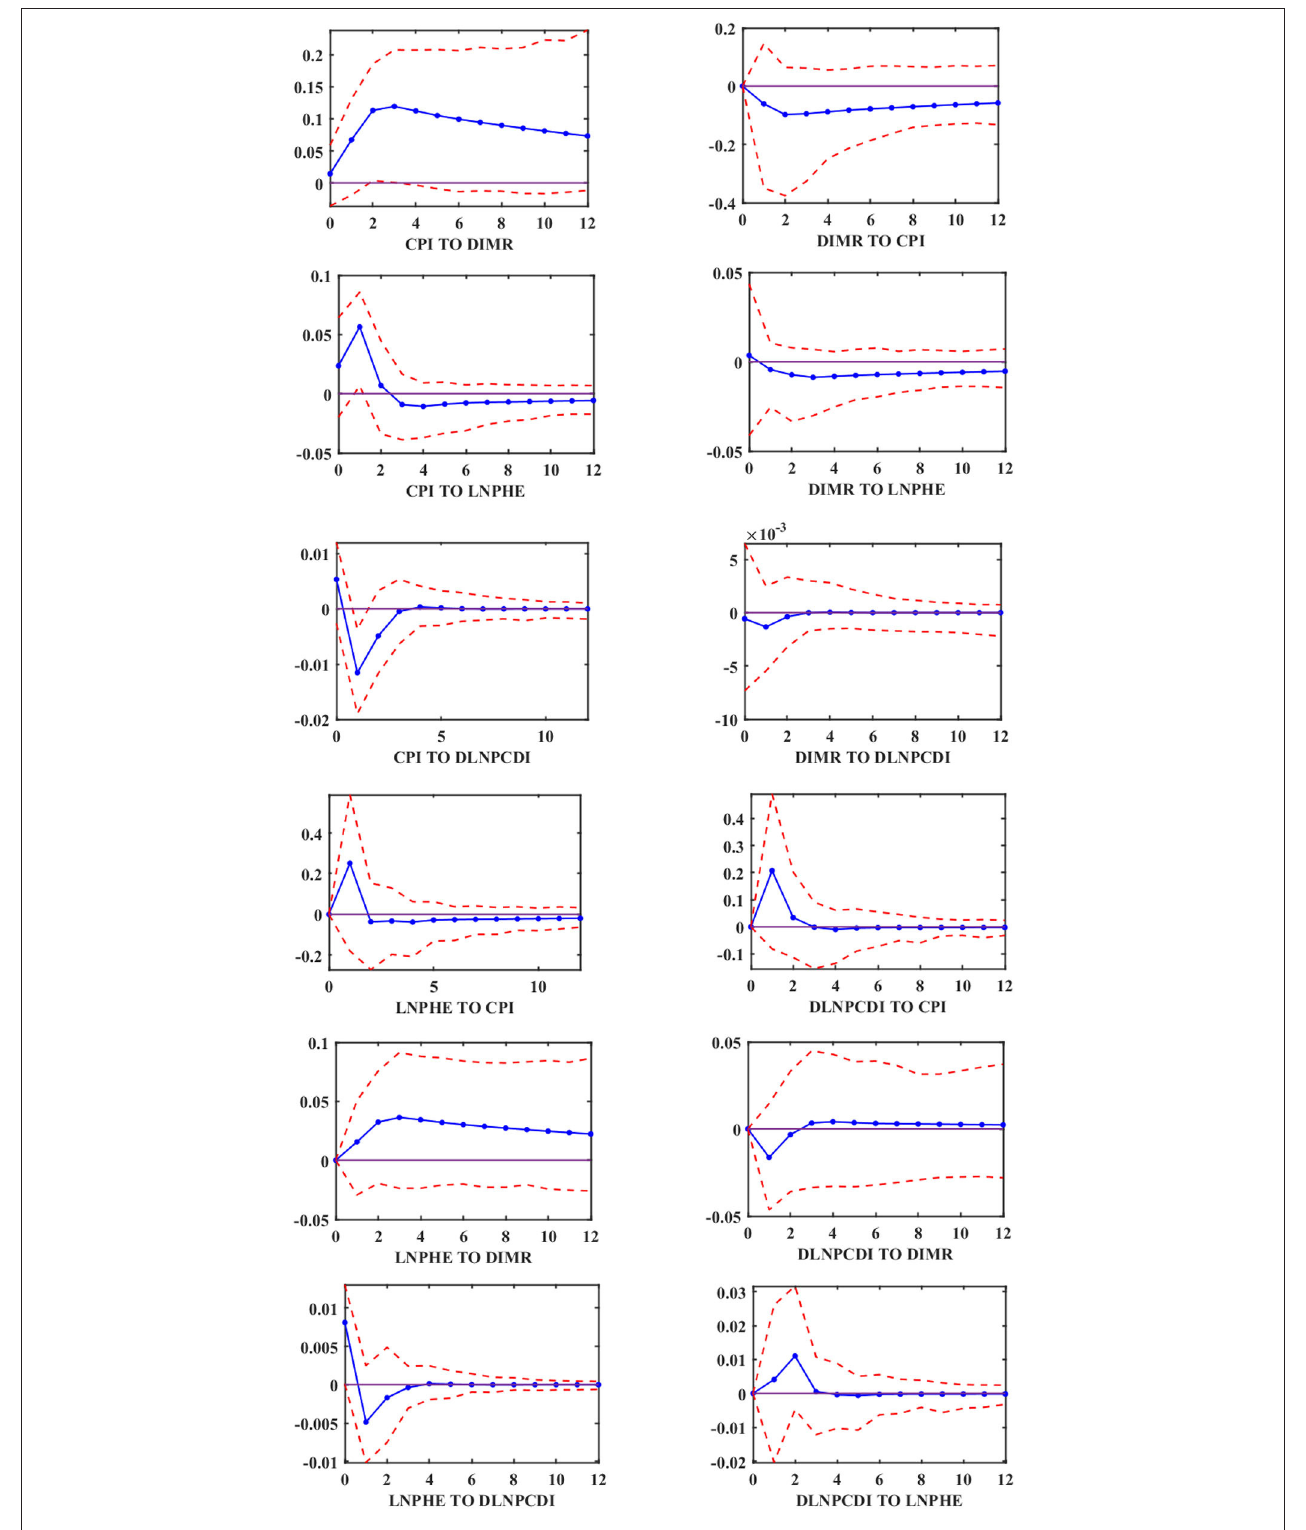
FIGURE 2 | Impulse response functions of LF-VAR.